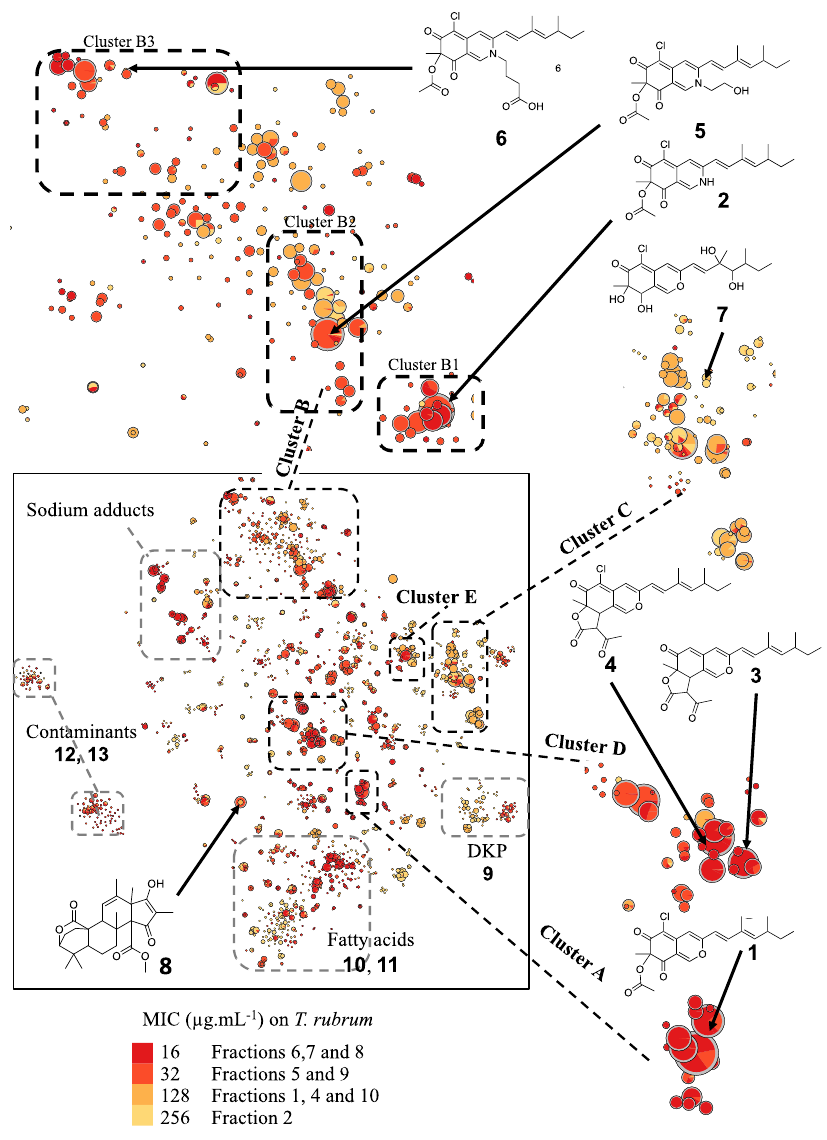
Figure 1. t-SNE molecular network representation constructed on MS² homology, with the size of the nodes related to their intensity and color to minimal inhibitory concentration (MIC) of fractions against T. rubrum with dereplicated features from MS² standard database query. Azaphilone derivative clusters are boxed in black.